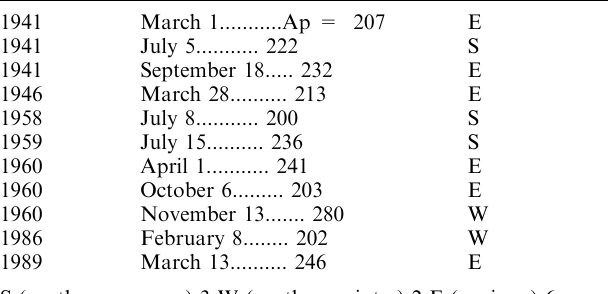
Table 4. 11 days of most intense storms with daily Ap (cid:21)